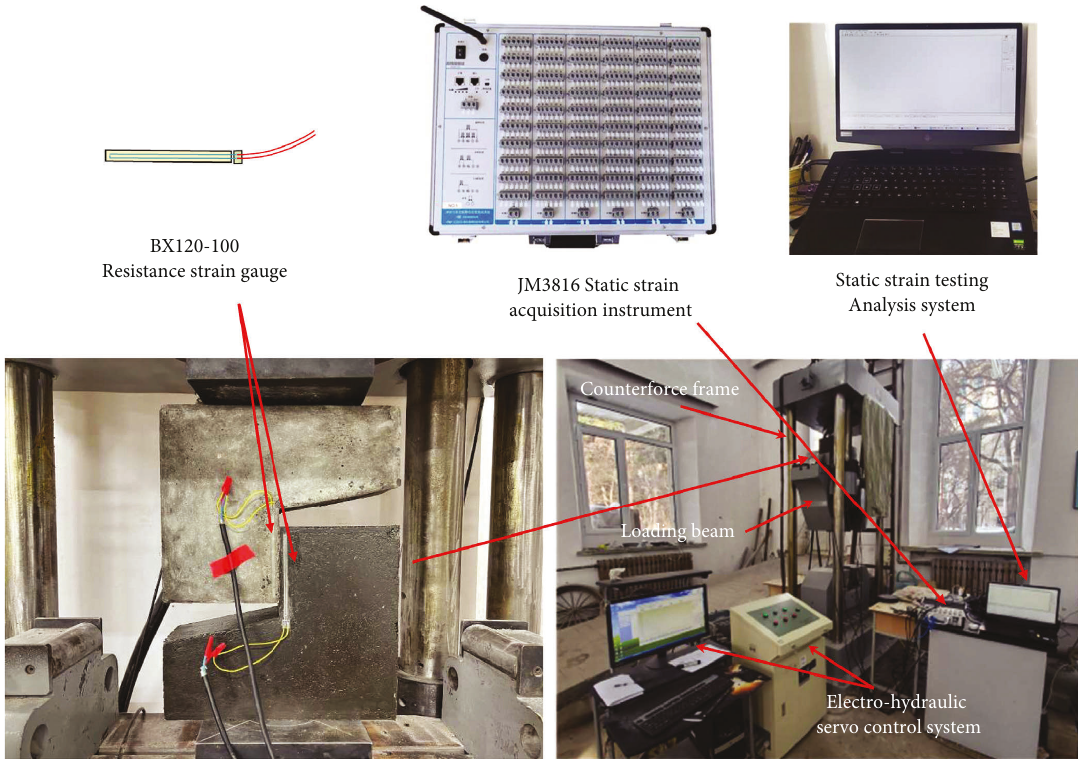
Figure 12: Direct shear bond strength test.